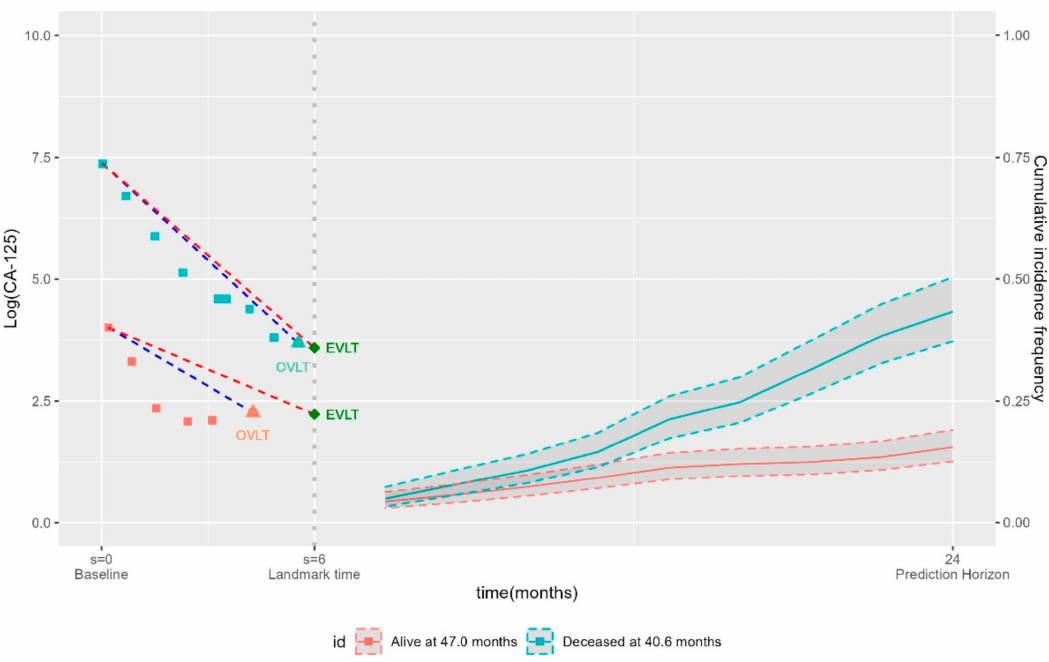
Figure 1. Illustration of the landmark framework. CA-125 trajectories of observed values up to the landmark time of s = 6 months for two patients at risk of death at the landmark time (#1 alive after 56.9 months, and #2 deceased after 24.5 months). Their overall survival was assessed at t = 24 months. Summaries of the early CA-125 trajectory were obtained from values up to the landmark time (the blue dashed lines represent the observed slope, and the red dashed lines represent the estimated